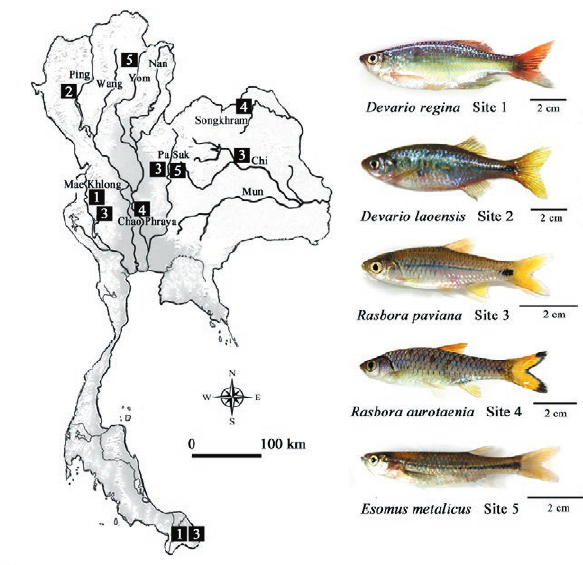
Figure 1. Collection sites of cyprinid fishes studied herein. 1= Devario regina, 2= Devario laoensis ; 3= Rasbora paviana , 4= Ras- bora aurotaenia , 5= Esomus metalicus